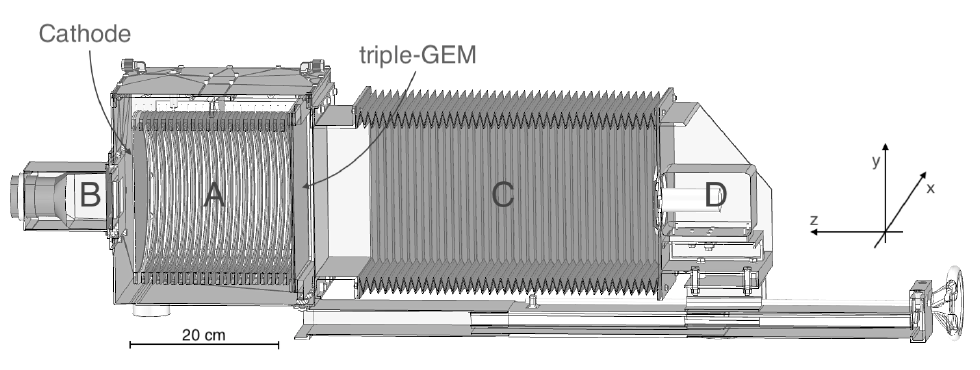
Figure 4. The L EMON prototype [49]. The elliptical sensitive volume ( A ), the fast photo-multiplier ( B ), the optical bellow ( C ) and the sCMOS-based camera ( D ) are indicated. L EMON standard operating conditions were based on the following